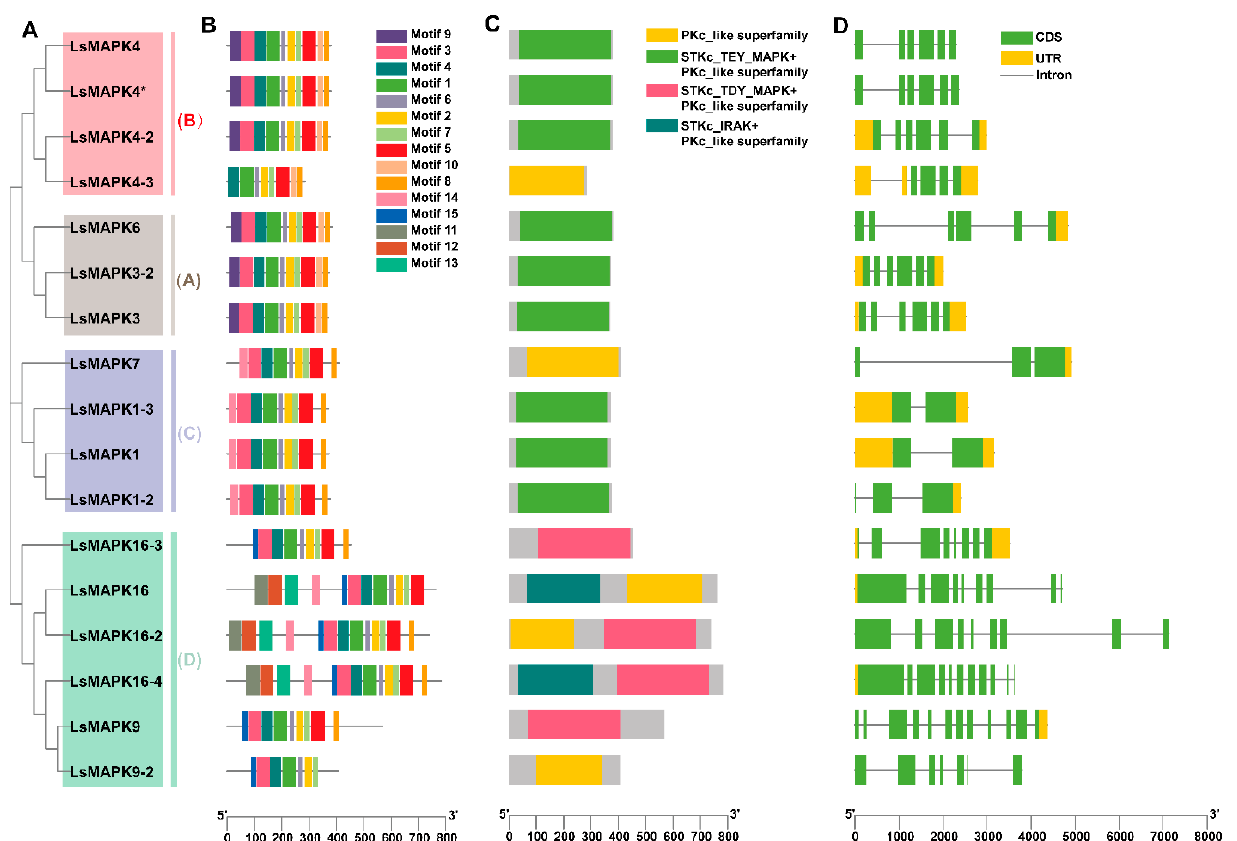
Figure 4. Gene structure analysis of LsMAPKs . LsMAPK gene family phylogenetic tree ( A ), motif distribution ( B ), conservative domain analysis ( C ), and intron–exon structure ( D ).